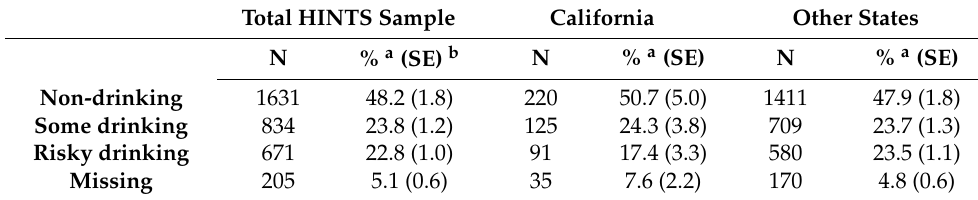
Table 2. Alcohol use among HINTS 5 cycle 4